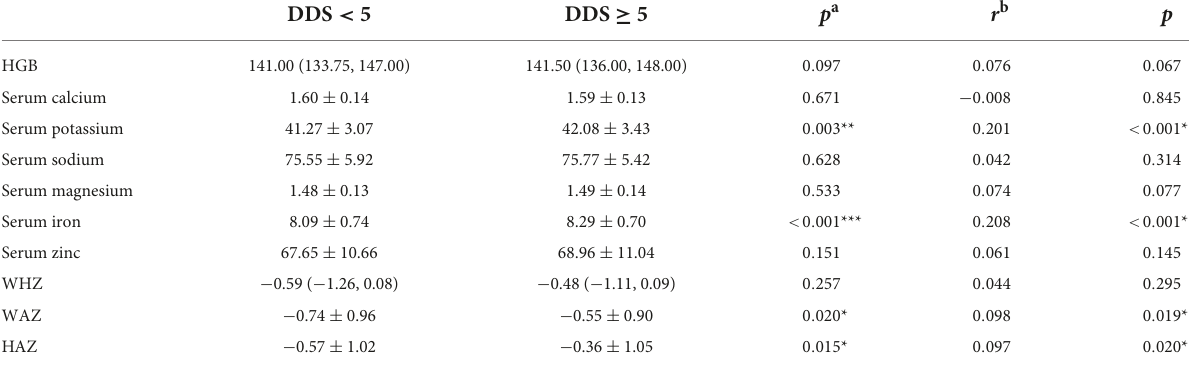
TABLE 2 Blood biomarkers and anthropometric status in low and high DDS groups.